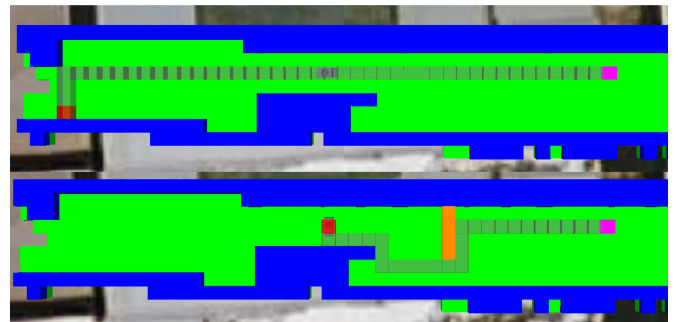
Figure 8. Path Planning Experiment 3, a real-time warning experiment. Blue indicates wall, red indicates starting point, purple indicates the end point, green indicates passable area, grey indicates the path, orange indicates obstacles.